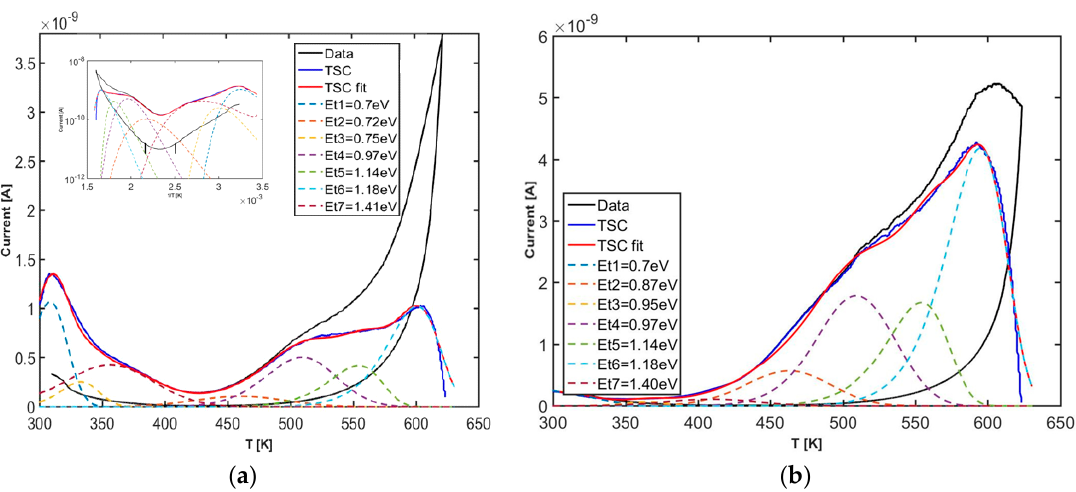
Figure 9. TSC after storage in ambient air ( T = 300 K) in humid environment ( rh = 20%) for ( a ) two days (inset: logarithmic plot) experimental data (black); TSC with background subtracted (blue); TSC best fit (red curve) obtained with a set of 7 peaks with energy E t0 given in the legend; ( b ) TSC measurements after four days storage and best fit with same E t0 parameters as in ( a ).